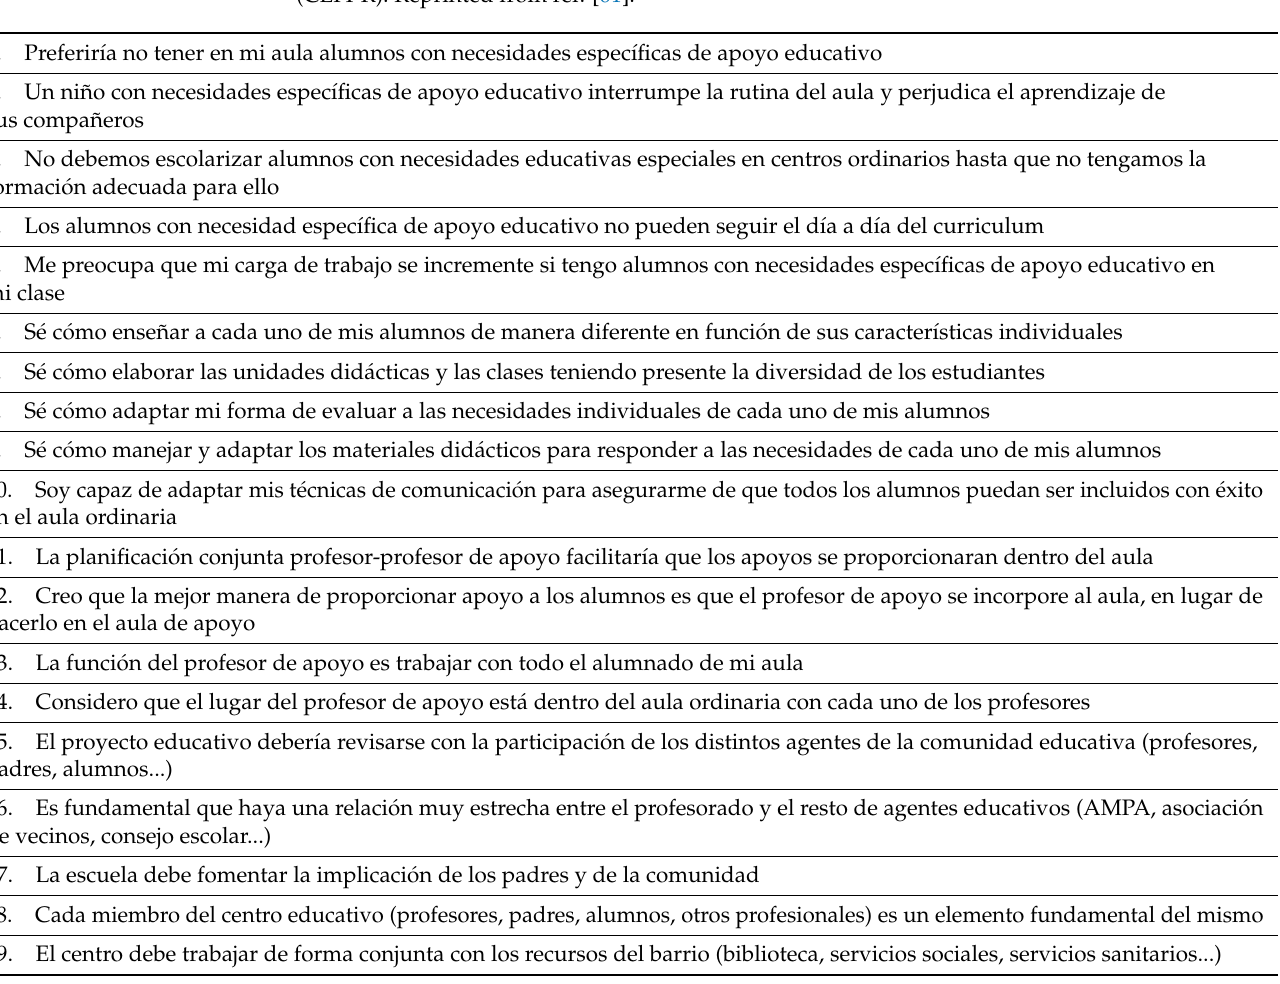
Table A2. Cuestionario para la Evaluaci ó n de la Preparaci ó n del Profesorado para la Inclusi ó n (CEFI-R). Reprinted from ref.